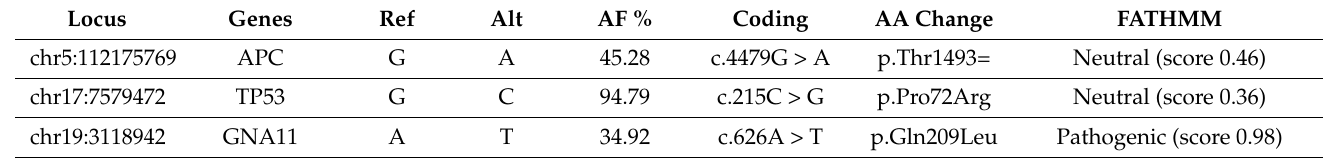
Table 1. Variants detected by next generation